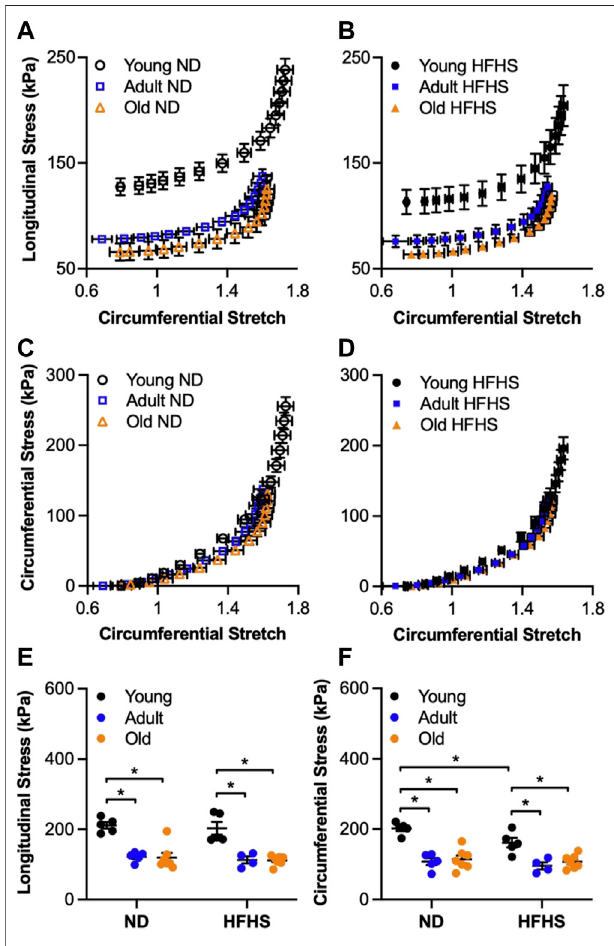
FIGURE 3 | Average (mean ± SEM) experimental longitudinal (A,B) and circumferential (C,D) Cauchy stress-stretch responses for the age (young, adult and old) and diet (ND and HFHS) groups. Cauchy stress at MAP in longitudinal (E) and circumferential (F) direction as a function of age (young, adult and old) and diet (ND and HFHS) (* p <